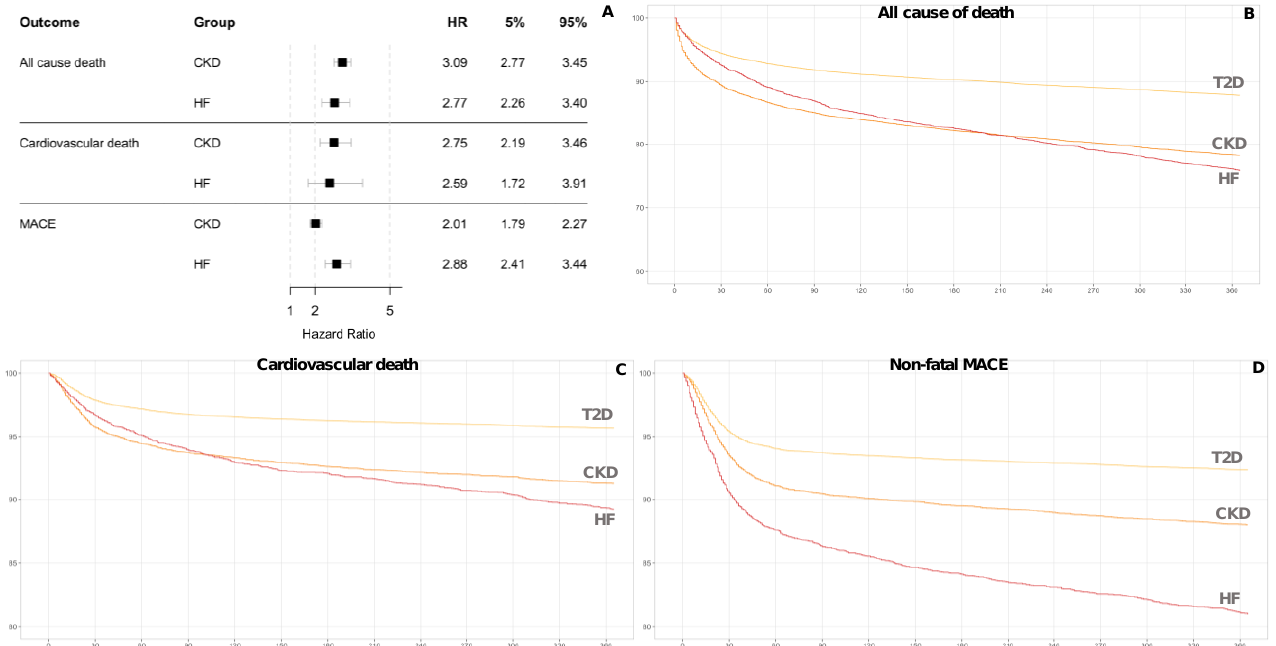
Figure 2. Adjusted relative hazard ratios (HRs) for chronic kidney disease (CKD) and heart failure (HF) using diabetes mellitus type 2 (T2D) ( A ), Kaplan–Meier survival curves for risk comparison regarding all-cause deaths ( B ), cardiovascular deaths ( C ), and major adverse cardiac events (MACEs) ( D ) at one year of follow-up as outcomes.